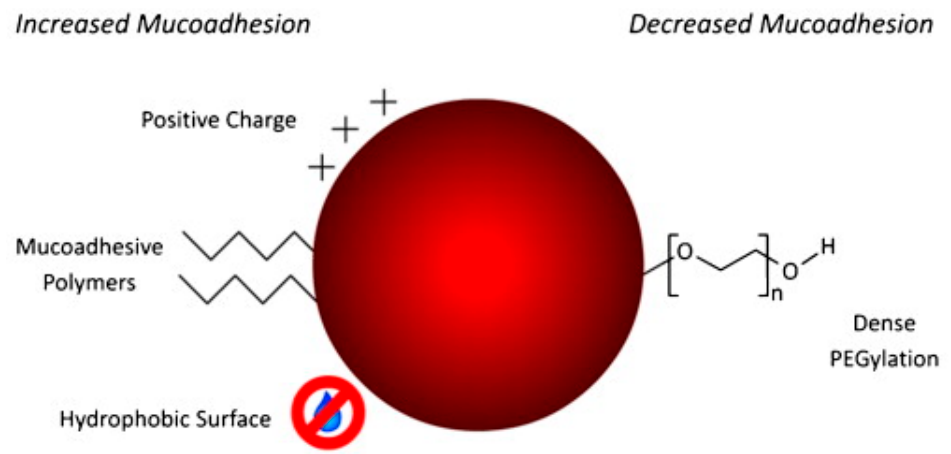
Figure 3. Surface chemistry of nanoparticles having an influence on mucoadhesion (modified with permission from [84]).